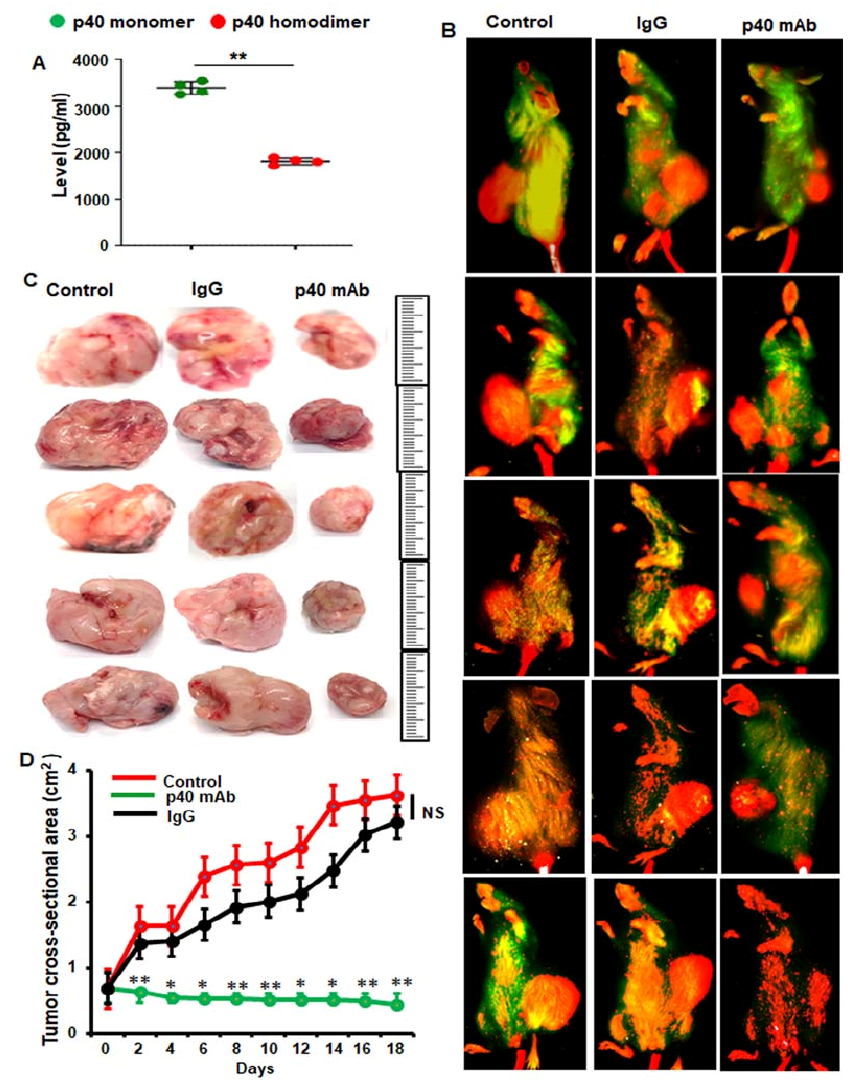
Figure 3. Regression of TNBC tumor in vivo in patient-derived xenograft (PDX) mice by p40 mAb. ( A ) Female 6–8 week old NOD scid gamma (NSG) mice were engrafted TNBC tumor fragments at passage P1-P9 (invasive ductal carcinoma; TNBC ER − / − /PR − / − /HER2 − / − ) in the flank. After 6 weeks of engraftment, levels of p40 and p40 2 were measured in serum by sandwich ELISA. Results are mean ± SEM of four mice ( n = 4) per group. ** p < 0.01. ( B ) After about 4 weeks of engraftment, when tumors of PDX mice ( n = 5 per group) were 0.6–0.8 cm 2 in size, mice were treated with p40 mAb (right panel) and hamster IgG (middle panel) at a dose of 2 mg/kg body wt once a week. After 2 weeks, tumors were labeled with Alexa800 conjugated 2DG dye via tail vein injection and then imaged in Licor Odyssey infrared imaging system. Results were compared with control group (Left panel). ( C ) Tumors were excised from the flank of all groups of mice. Five mice ( n = 5) were included in each group. ( D ) Tumor size was monitored every alternate day. Results are mean ± SEM of five different mice.